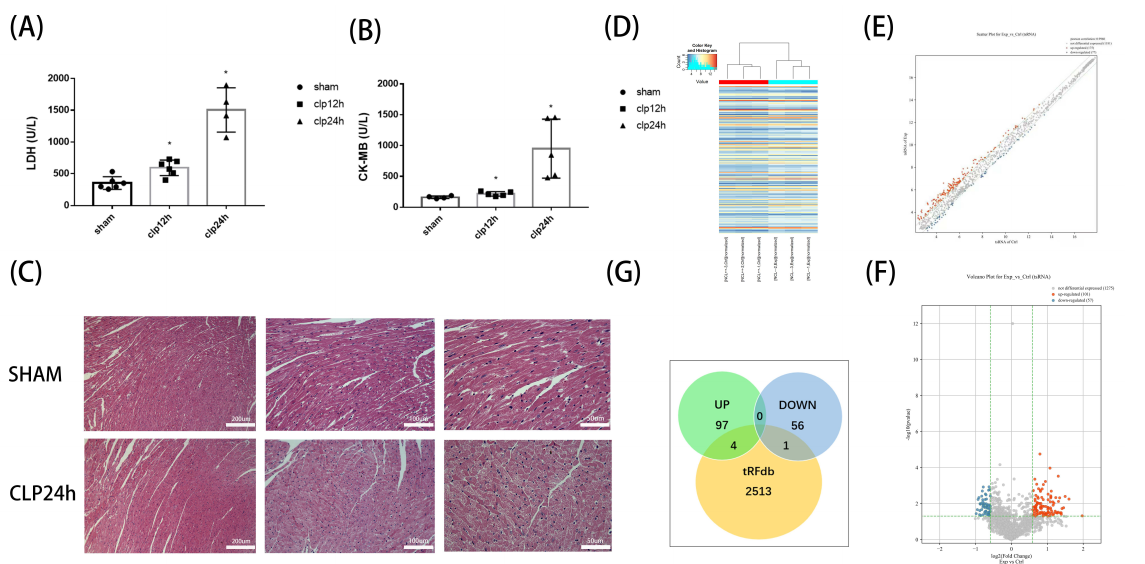
Figure 1. Alterations of tsRNA expression profiles induced by septic cardiomyopathy. ( A ) Compari- son of CK-MB in myocardial tissue of CLP group versus SHAM group. * p < 0.05. ( B ) Comparison of LDH in myocardial tissue of CLP group versus SHAM group. * p < 0.05. ( C ) Comparison of myocardial HE staining between CLP Group and SHAM group. ( D ) Septic cardiomyopathy-related tsRNAs were shown in the heat map. The colors in the panel indicate the relative expression levels (log2 transformation). The color bar graph on the top panel shows the sample group at the top. ( E ) The scatter plot showed that there were 158 significantly altered tsRNAs between CLP and SHAM groups ( p < 0.05, FC ≥ 1.5). ( F ) The volcano plot showed that there were 158 significantly altered tSNAs between CLP and SHAM groups ( p < 0.05, FC ≥ 1.5). Red showed up-regulated tsRNAs and blue showed down-regulated tsRNAs. Data were presented as the mean ± standard deviation ( n =